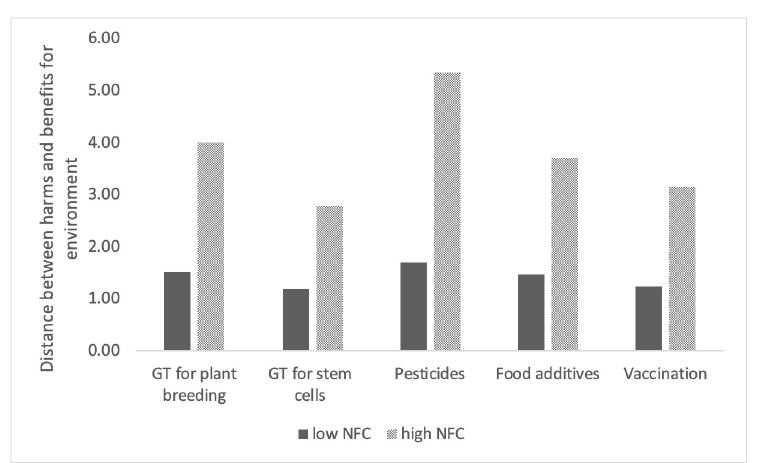
Fig 3. Distance between harms and benefits for the environment for two groups: Low and high in NFC.